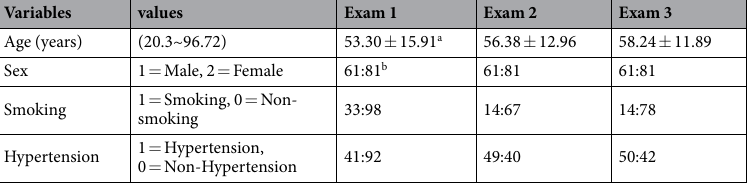
Variables QIF (S.E) a pQIF Intercept 3.438 (1.458) 0.054 Age 6.903 (2.391) 2.199 Gender 2.829 (1.082) — Smoking 1.170 (0.861) — AGTR1 − 4.546 (1.697) − 0.889 ADRA1B − 0.916 (0.627) — GNAQ − 3.311 (1.335) — PLCB3 − 0.008 (0.611) — PRKCA − 1.598 (0.953) — PPP1CA 1.906 (0.857) — CAMK2A − 0.535 (0.532) — CALM3 − 1.593 (0.690) — RYR2 − 0.883 (0.645) — PPP2CA 4.688 (1.826) — CREB3L2 − 0.240 (0.367) — Table 4. The coefficients estimated by the QIF and pQIF methods. AGTR1, ADRA1B, GNAQ, PLCB3, PRKCA, PPP1CA, CAMK2A, CALM3, RYR2, PPP2CA, and CREB3L2 were genes in the Ca2 + /AT-IIR/ α -AR signaling pathway. Other covariates in the analysis were age, gender, and tobacco smoking. The notation “—” indicates that the coefficient of the related variable was penalized to 0. a S.E = standard error of the coefficient